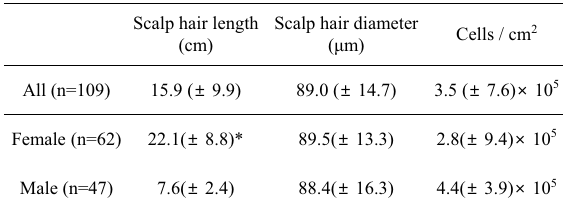
Table 2. Measurement of the length and diameter of scalp hair shaft, and quantification of the bacterial cell number on scalp hair shafts by qPCR of the 16S rRNA gene copy. * indicates significantly high number between female and male.